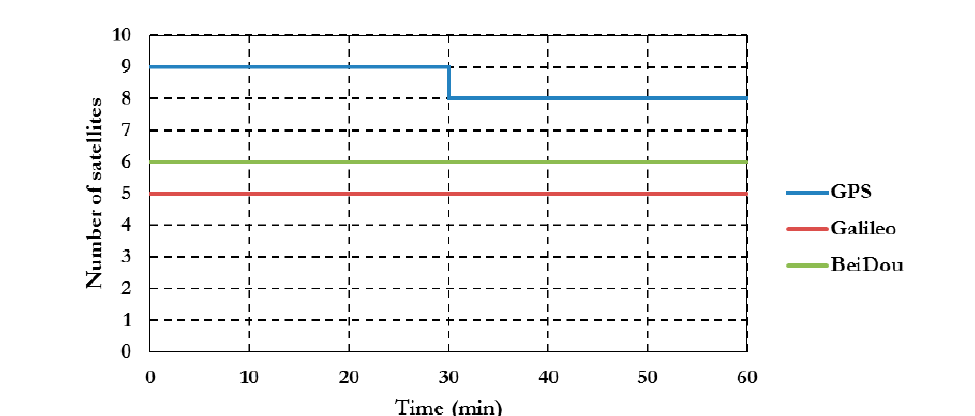
Figure 2. DLF1 station GNSS satellite availability.